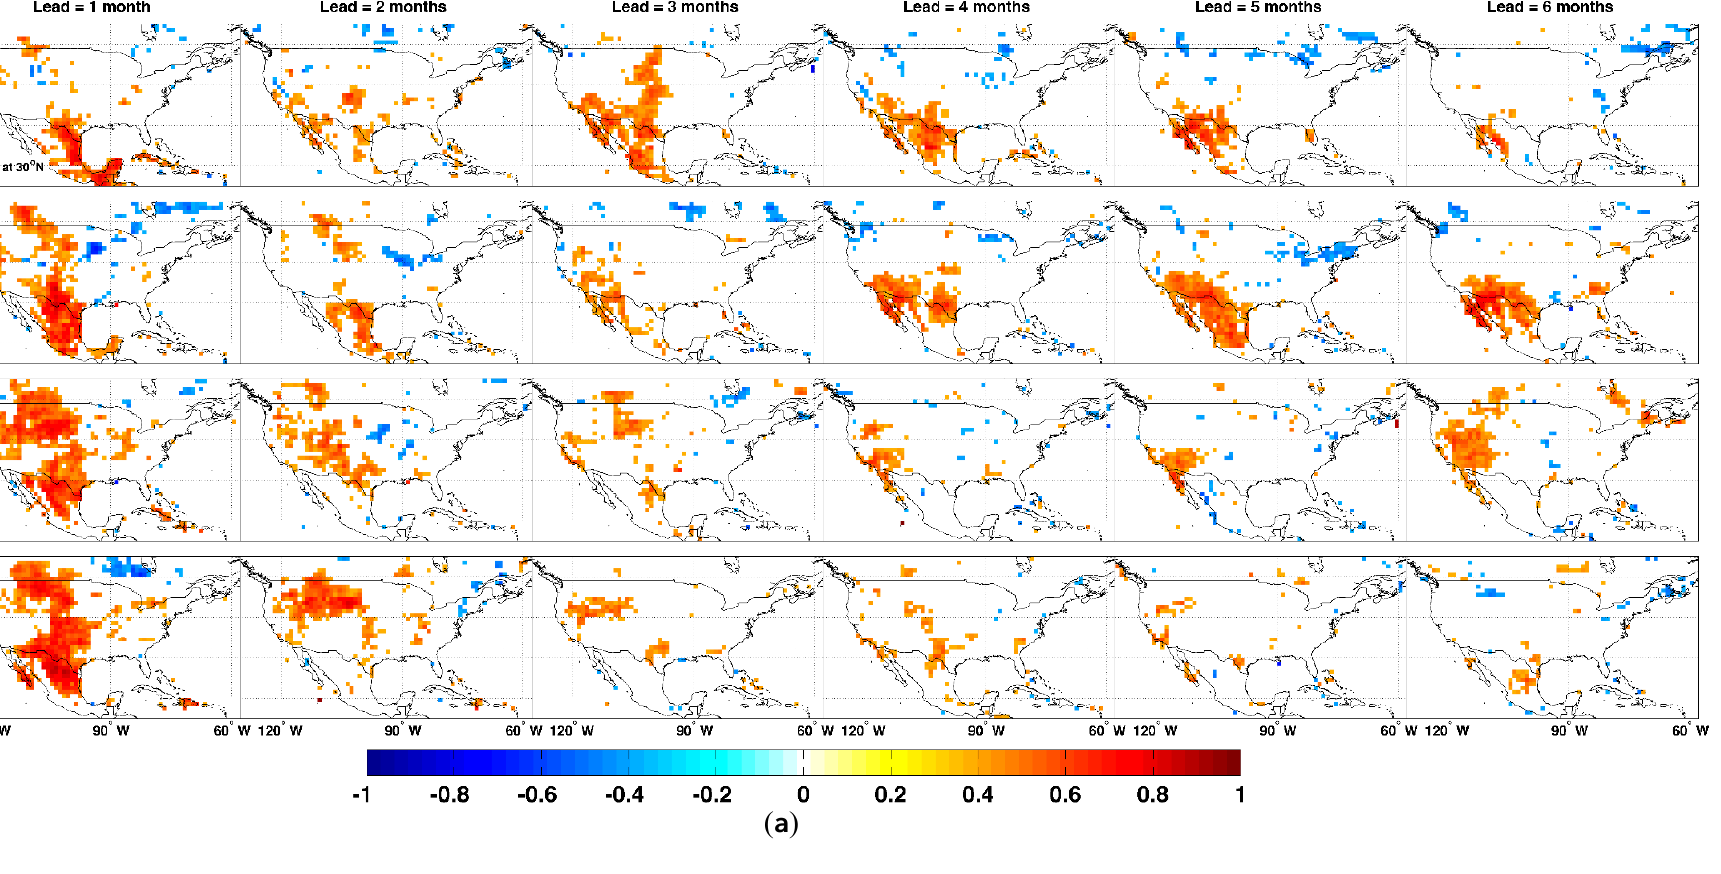
Figure 5. Regional maps of correlation coefficients ( p < 0.05) between month-specific GIMMS NDVI and GPCP precipitation anomalies with varying leads (N = 29, 1982 – 2010): ( a ) North America and ( b ) Australia (Spatial resolution: